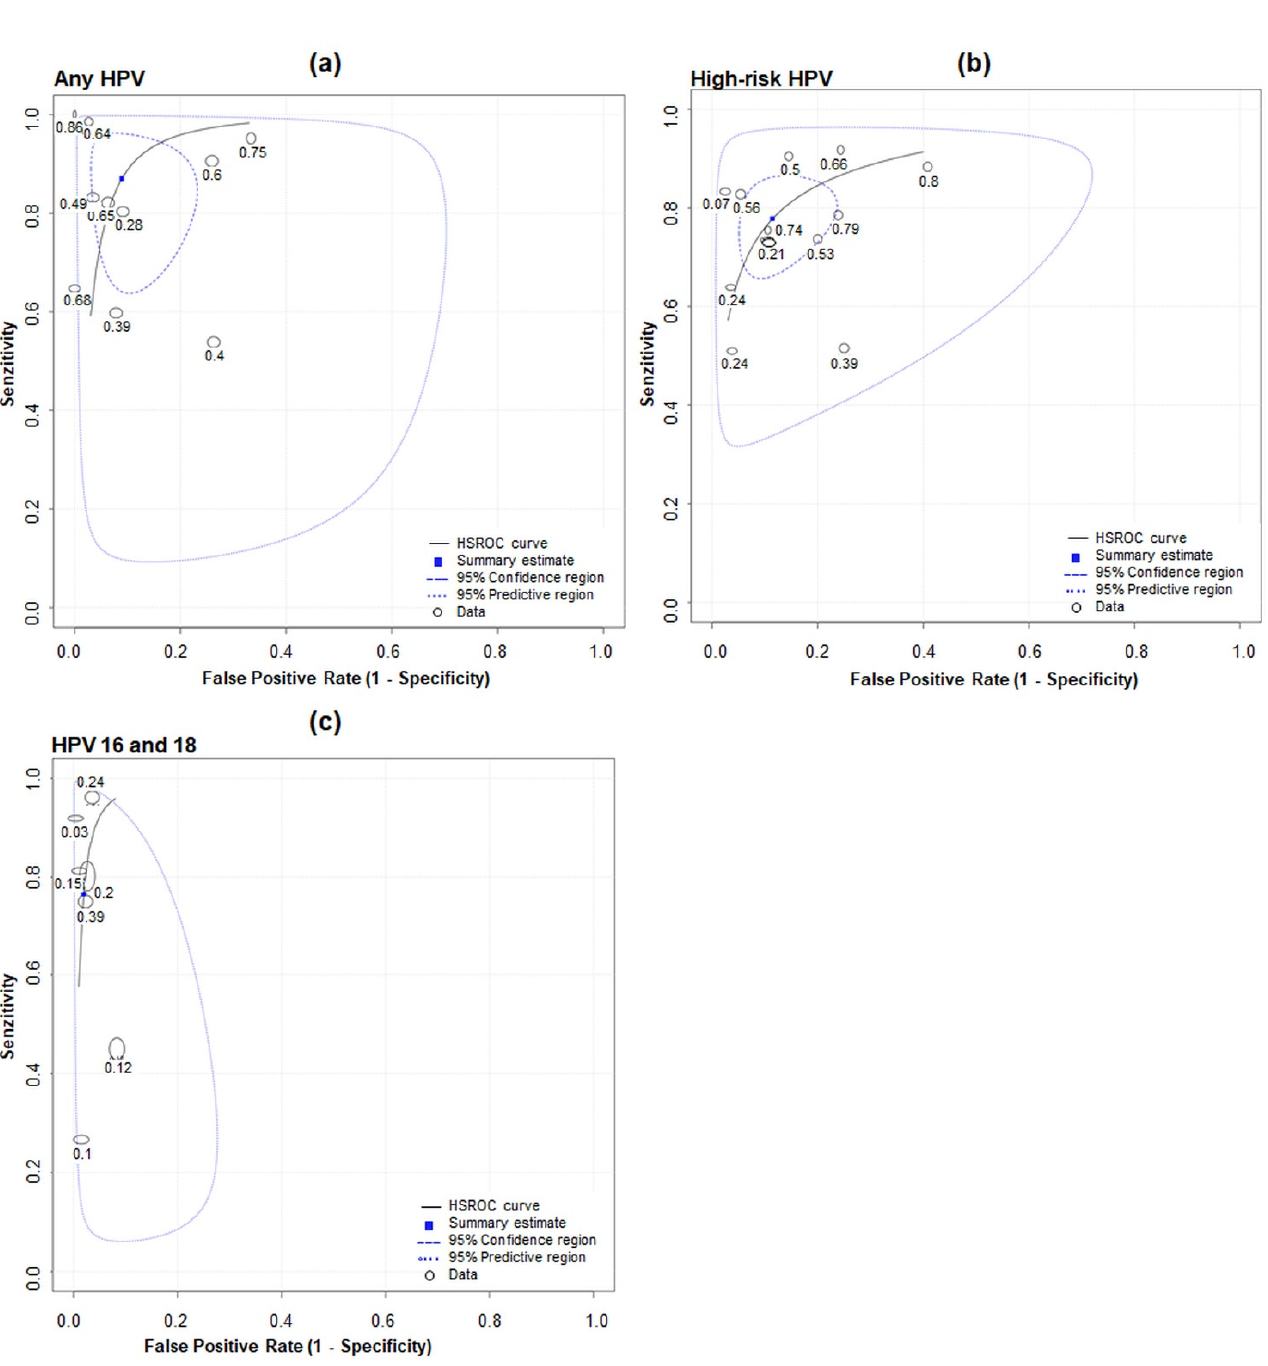
Figure 4. SROC plot for studies evaluating accuracy of detecting ( a ) any HPV, ( b ) high-risk HPV and ( c ) HPV 16 and 18 in first-void urine compared with in cervix.